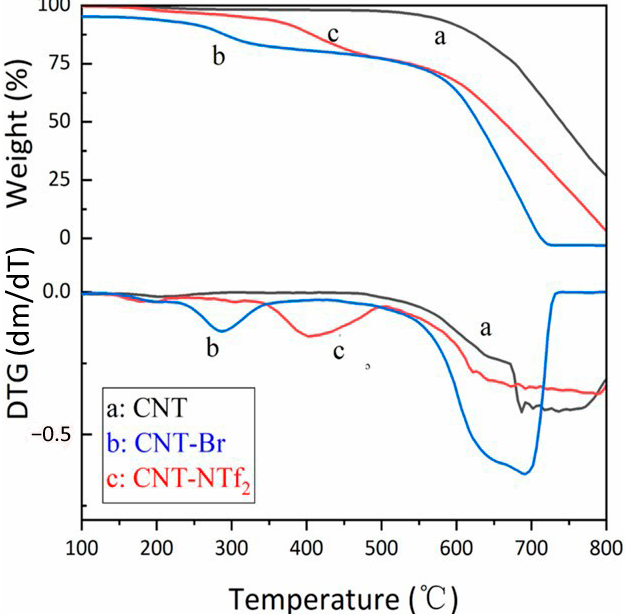
Figure 4. TGA and DTG of CNT ( a ), CNT-Br ( b ), and CNT-NTf 2 ( c ). TGA is the thermogravimetric analysis and DTG is the first derivative of TG in which m and T are indicators of mass loss and temperature, respectively. With permission [26].